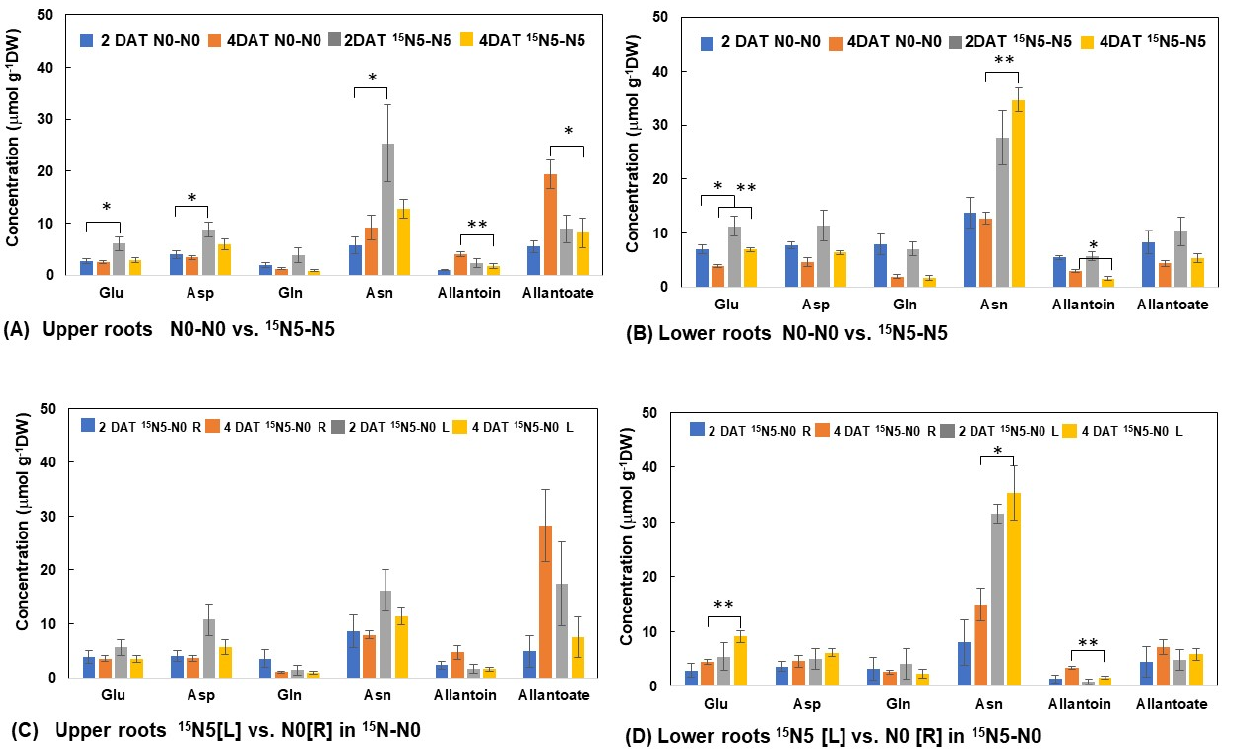
Figure 7. Comparison of the concentrations of principal N metabolites in the upper roots ( A ) and the lower roots ( B ) of soybean plants with split root experiments with N0-N0 and 15 N5-N5 treatments, and the concentrations of N compounds in the upper roots ( C ), and the lower roots ( D ) of soybean in which either half-root were supplied with N-free solution of 5 mM nitrate in 15 N5-N0 treatment. The * and ** indicate the significant differences between N0 and N5 conditions based on Student’s T-test ( p < 0.01, and 0.01 < p < 0.05). ( A ) N = (8), ( B ) N = (4). Average ± SE.